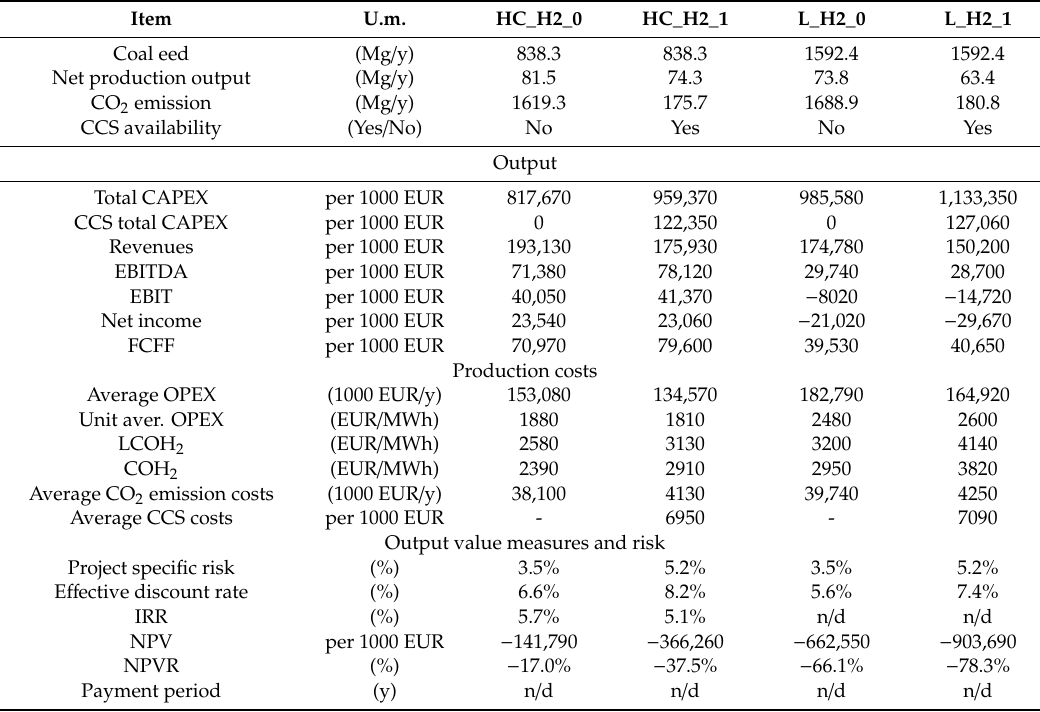
Table 8. The results for the basic